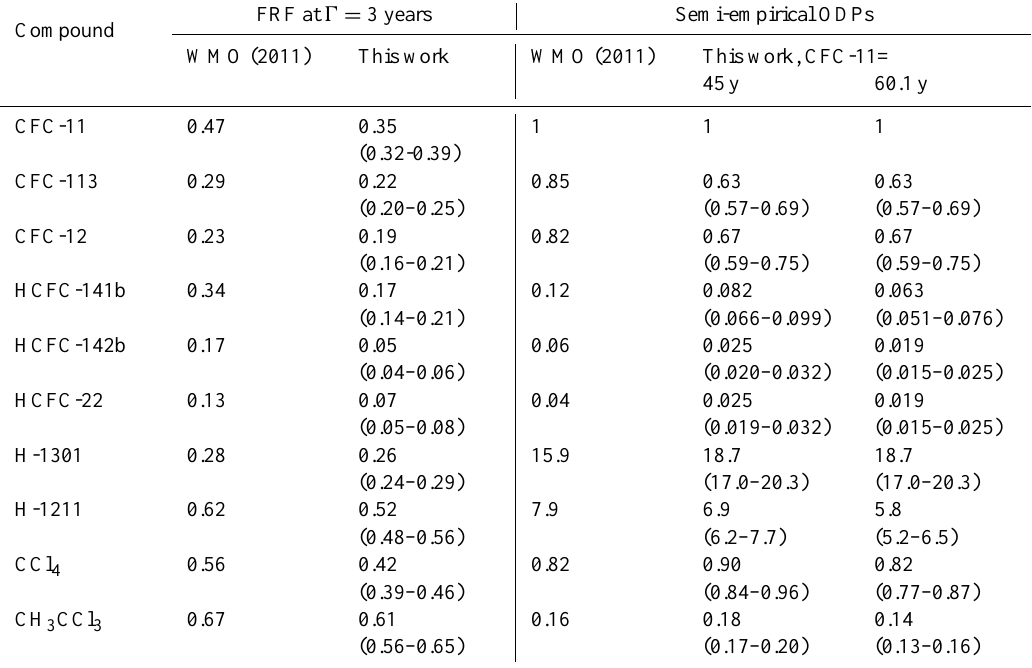
Table 3. Overview of FRFs derived from mid-latitude polynomial fit functions (see Supplement) at a mean age of 3 years. Uncertainties are calculated by fitting polynomials through the upper and lower envelopes exhibited by the FRF and mean-age error bars displayed in Figs. 3 to 5. Also shown are semi-empirical ozone depletion potentials calculated using these FRFs and the stratospheric lifetimes from Table 2 in comparison to recent estimates from WMO (2011). The ODP ranges additionally consider the stratospheric lifetime ranges from Table